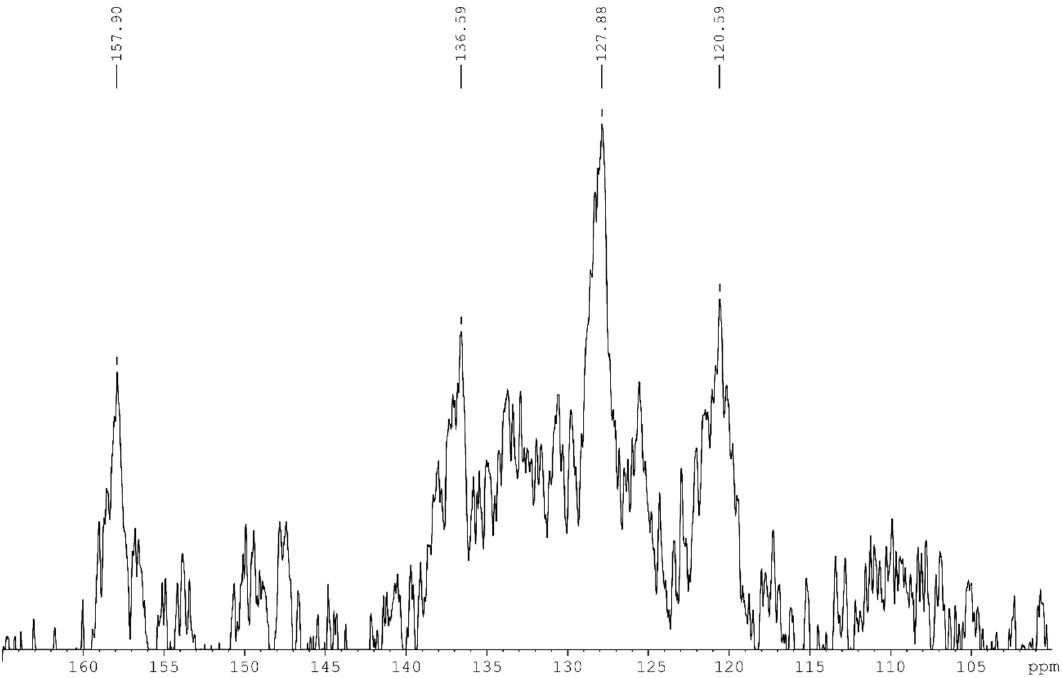
Figure 2. 13 C NMR spectrum for SPNBI-I,III in D 2 SO 4.